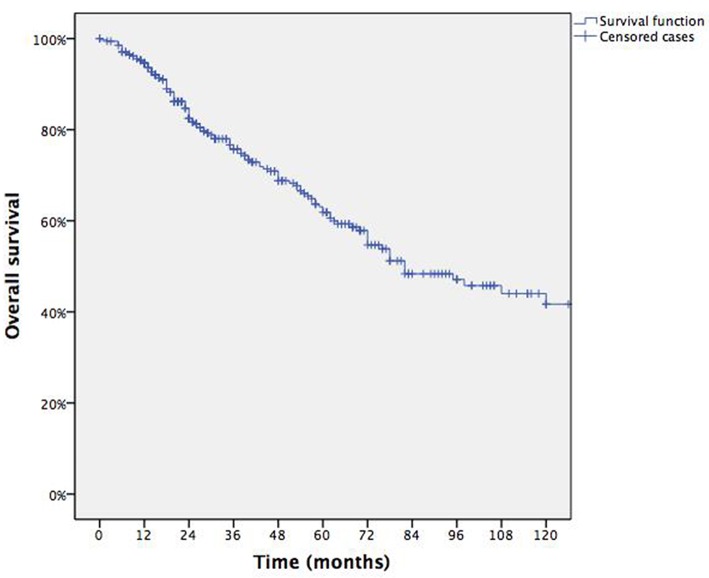
Overall survival.